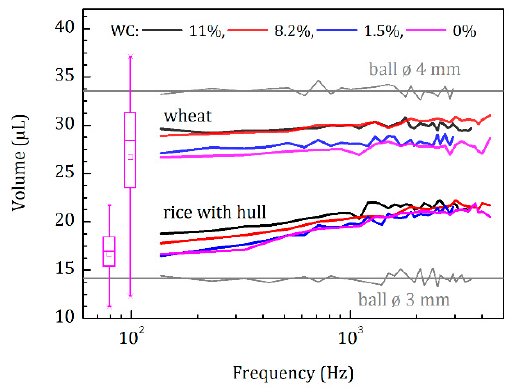
Figure 8. Measurements of wheat and rice seeds at different frequencies. Mean measured volume of 24 seeds versus frequency at 11% (black), 8.2% (red), 1.5% (blue), and 0% (magenta) moisture levels, i.e., water content (WC) by mass. Gray curves and horizontal lines show the measured and calculated volumes of polyoxymethylene (POM) calibration balls with known diameters, respectively. Magenta box charts reflect the variabilities of the respective measured values at the lowest frequency and at WC = 0%.